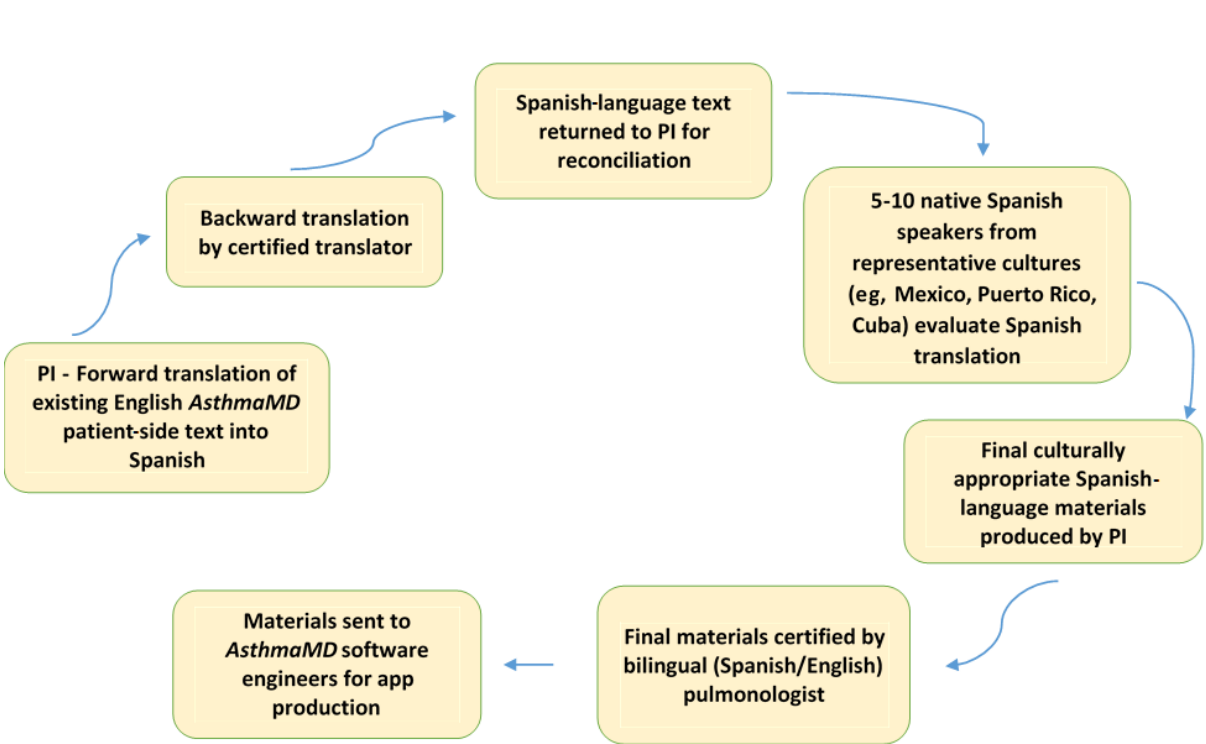
Figure 1. Systematic translation process of an existing asthma management app. PI: principal